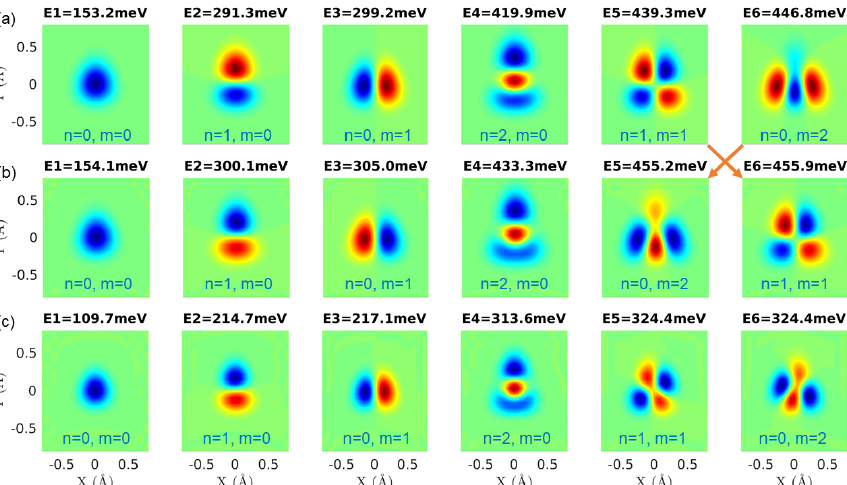
Figure 6. Lowest six eigenfrequencies and wavefunctions plotted in the range [ − 0.8, 0.8] Å × [ − 0.8, 0.8] Å by solving the Schrödinger equation for ( a ) (112) plane of (cid:101) -ZrH 2 , ( b ) ( − 112) plane of γ -ZrH, and ( c ) ( − 112) plane of γ -ZrD. Corresponding quantum numbers are denoted in [ n , m ] , where n is in the Y direction and m is in the X direction. Another interesting finding is that a crossover (marked by orange arrows) happens between the quantum numbers of (cid:101) -ZrH 2 and γ -ZrH, which are marked by orange arrows. The last two energy levels in γ -ZrD are degenerate. The Schrödinger equations were solved using